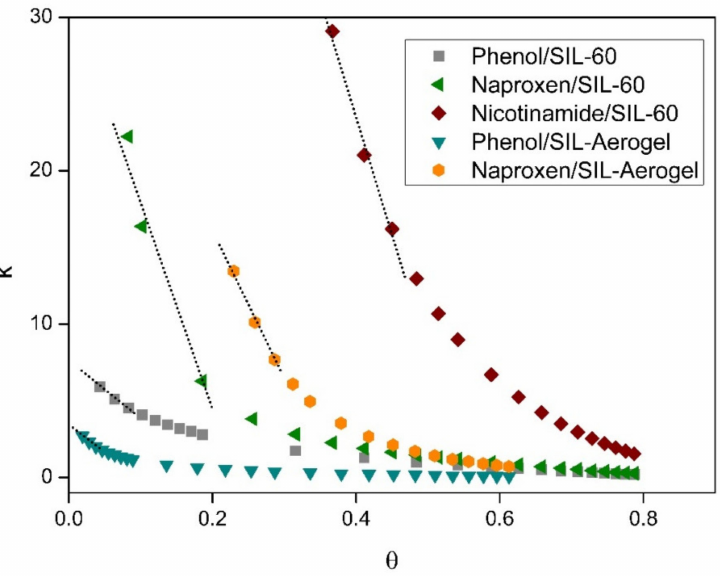
Figure 6. Retention factors of various solutes on SIL60 and SIL-Aerogel. SFC conditions: 200 bar, 40 ◦ C, injection volume 2 µ L, flow rate 2 mL min − 1 , modifier (methanol) fraction at 0.1–30 vol.%. The dashed straight lines were plotted to guide the eyes at low